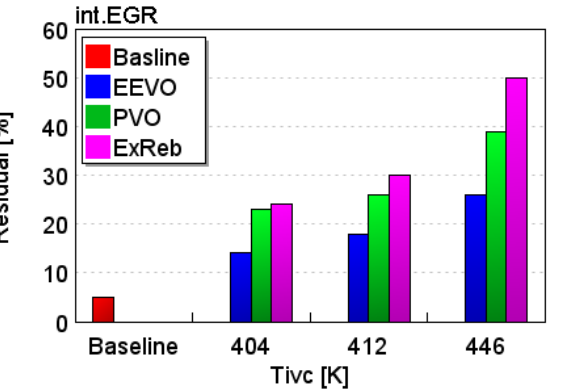
Figure 9. Comparison of int.EGR portions requirements among the strategies at different Tivc levels.